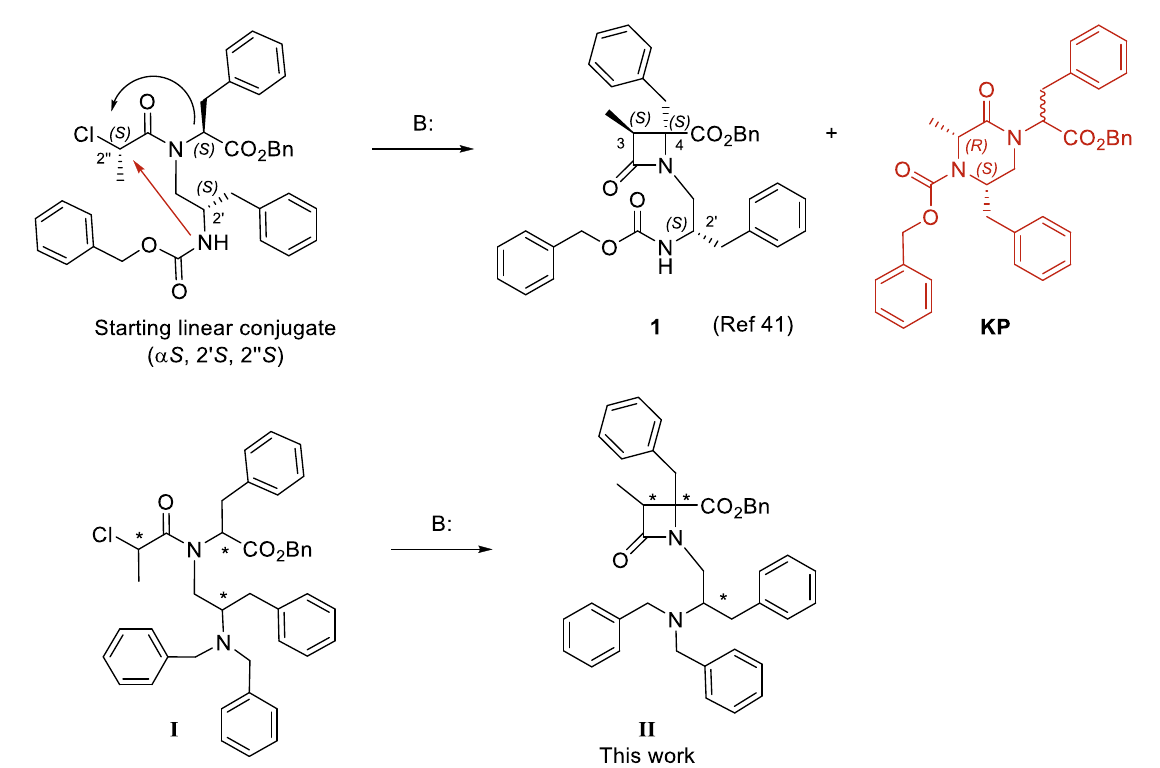
Figure 1. Previously described β– lactam ( 1 ) with transient receptor potential cation channel subfamily M member 8 (TRPM8) antagonist properties and analogues in this work ( II ), obtained from linear conjugates I . The black arrow denotes cyclization to β– lactam and red arrow to ketopiperazine ( KP ). * Means the position of stereogenic centers.